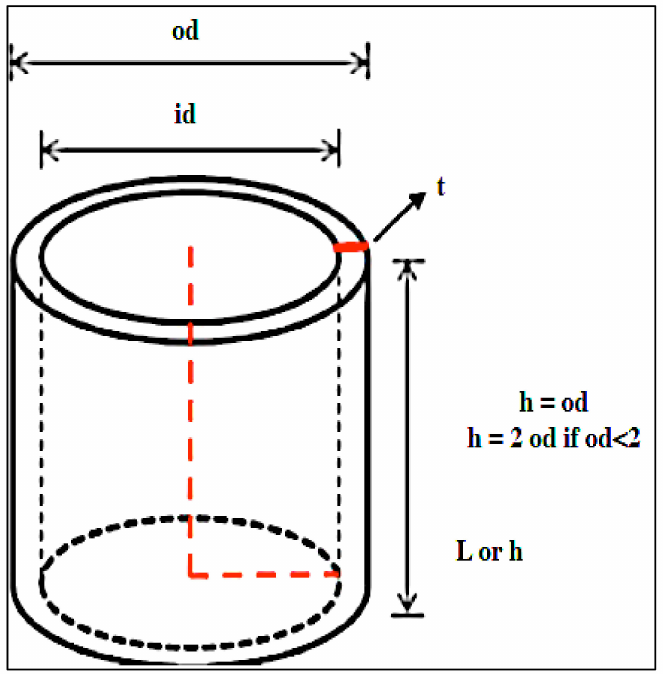
Figure 4. Sample used for the compression